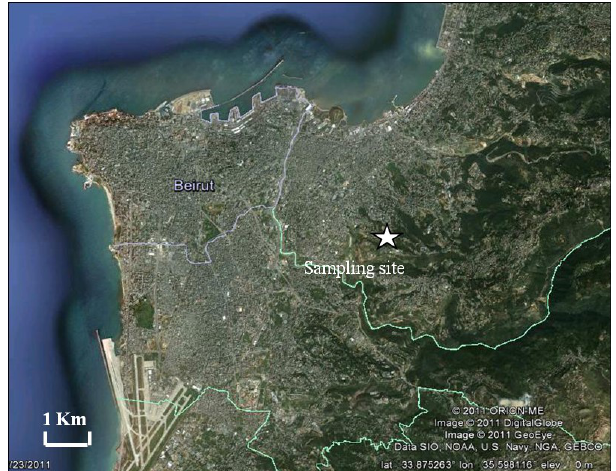
Figure 1. Sampling site in the eastern suburb of the city of